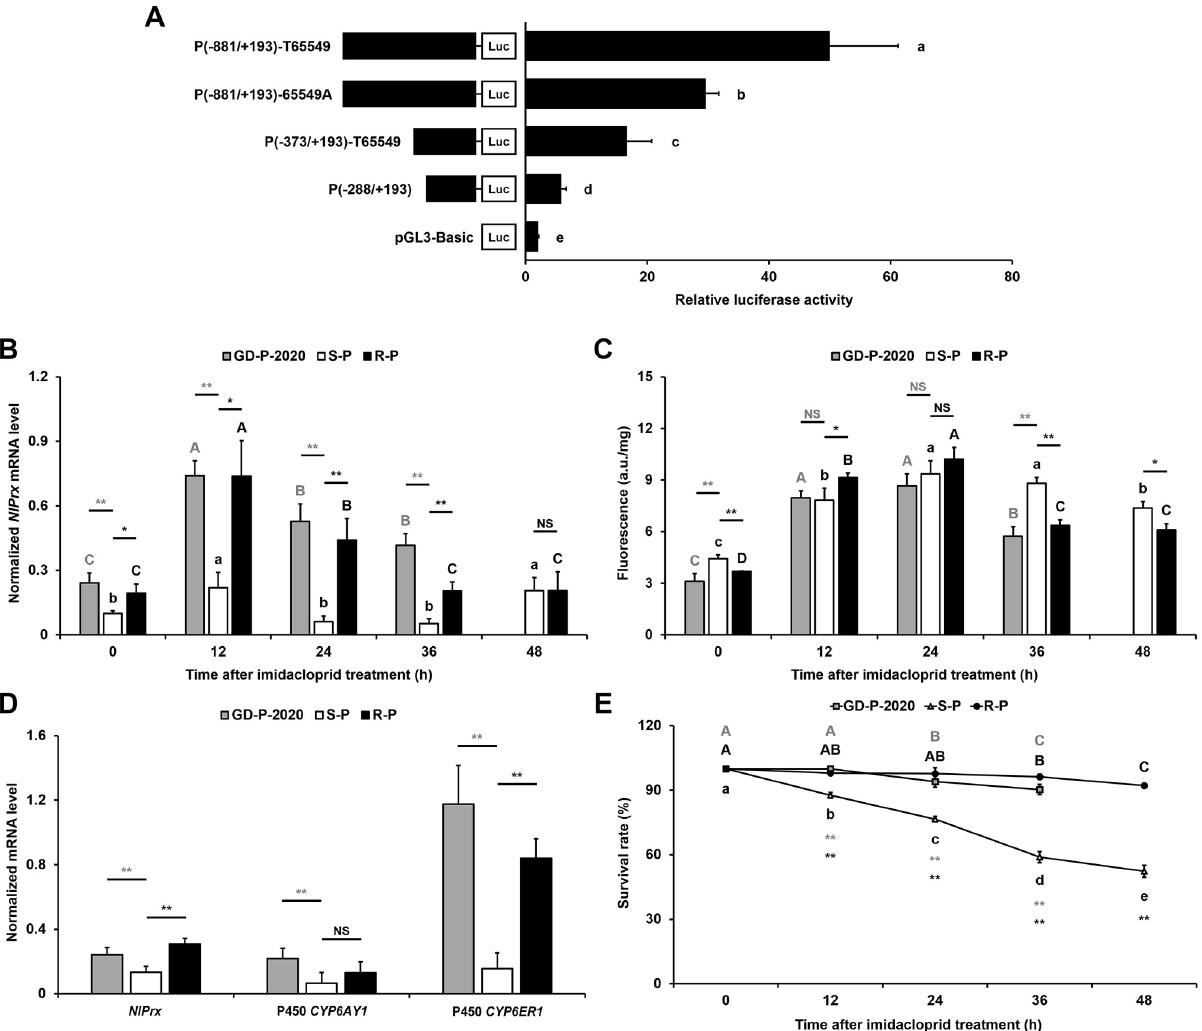
Fig 3. Impacts of NlPrx T65549 allele on NlPrx expression, ROS level, and survivorship in the absence and presence of imidacloprid. (A) The contribution of the T65549 allele to the promoter activity of NlPrx . The numbers in parentheses of the NlPrx promoter constructs specify the beginning and end positions of the promoter fragments. (B) Time course of NlPrx expression in GD-P-2020, S-P, and R-P in response to 10 mg/l imidacloprid. (C) Time course of the ROS burst elicited by 10 mg/l imidacloprid in GD-P-2020, S-P, and R-P. (D) Constitutive expression levels of NlPrx , CYP6ER1 , and CYP6AY1 in GD-P-2020, S-P, and R-P. Data represent the mean value ± SD of 3 biological replicates ( n � 3). (E) Time course of the survival rate with 10 mg/l imidacloprid in GD-P-2020, S-P, and R-P. Values sharing the same letter (lowercase letters for S-P and capital letters for GD-P-2020 and R-P) are not significantly different at P < 0.05 (1-way ANOVA and Duncan’s multiple range test). Extremely significant ( P < 0.01) and significant ( P < 0.05) differences between GD-P-2020/R-P and S-P (B–E) or the 2 promoter constructs (A) are depicted by double and single asterisks (Student t test), respectively. NS, no significant difference; ROS, reactive oxygen species. Numerical values are provided in S1 Data (doi: 10.6084/m9.figshare. 14177009).